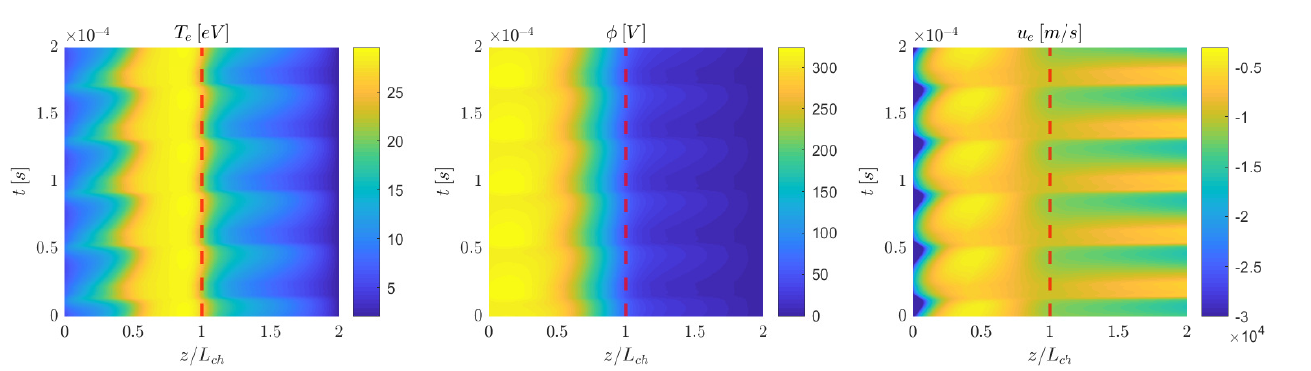
Figure 8. Space–time simulated plasma properties: ( left ) electron temperature, ( middle ) plasma potential, ( right ) electron velocity. The red dashed line indicates the channel